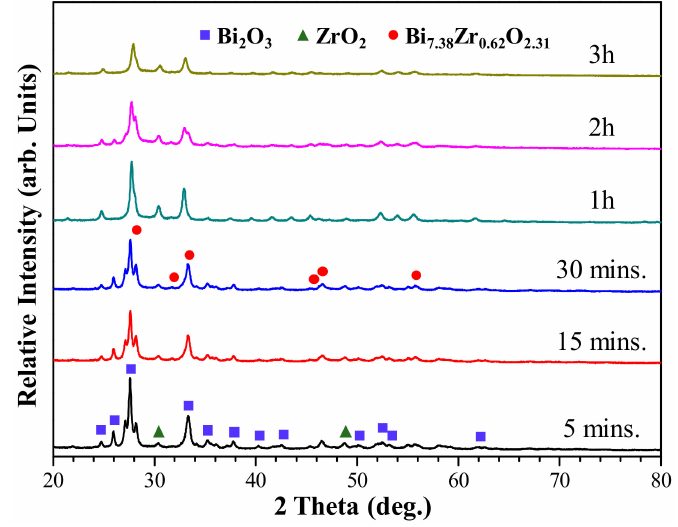
Figure 1. X-ray di ff raction patterns of 5% zirconia-added bismuth oxide powder mixture as